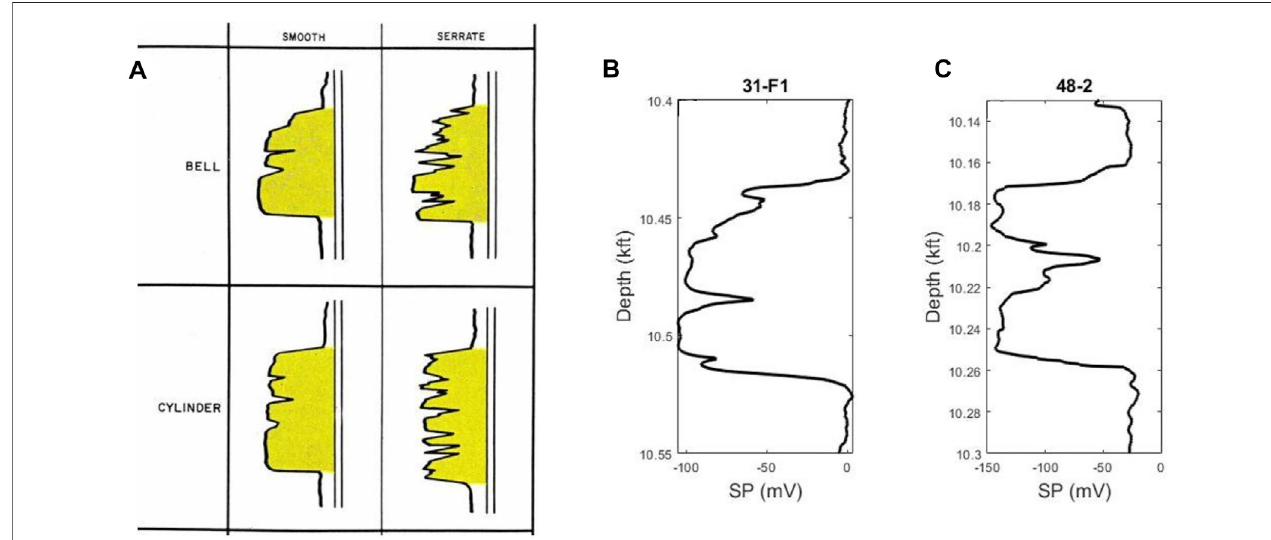
FIGURE2| Faciesidenti fi cation fromSPlog. (A) TypicalSPlogsignaturesforpointbars (bellshape) andchannels(cylindricalshape),asadapted from(Wilsonand Nanz, 1959), (B) point bar and (C) channel facies identi fi ed from SP log readings for wells31-F1 and 48-2, using the Cran fi eld dataset. shale breaks, type fi ed by sudden increase in SP logs readings are prominent trends observed for the Cran fi eld reservoir